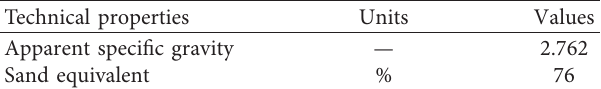
Table 4: Technical properties of fine aggregate in this